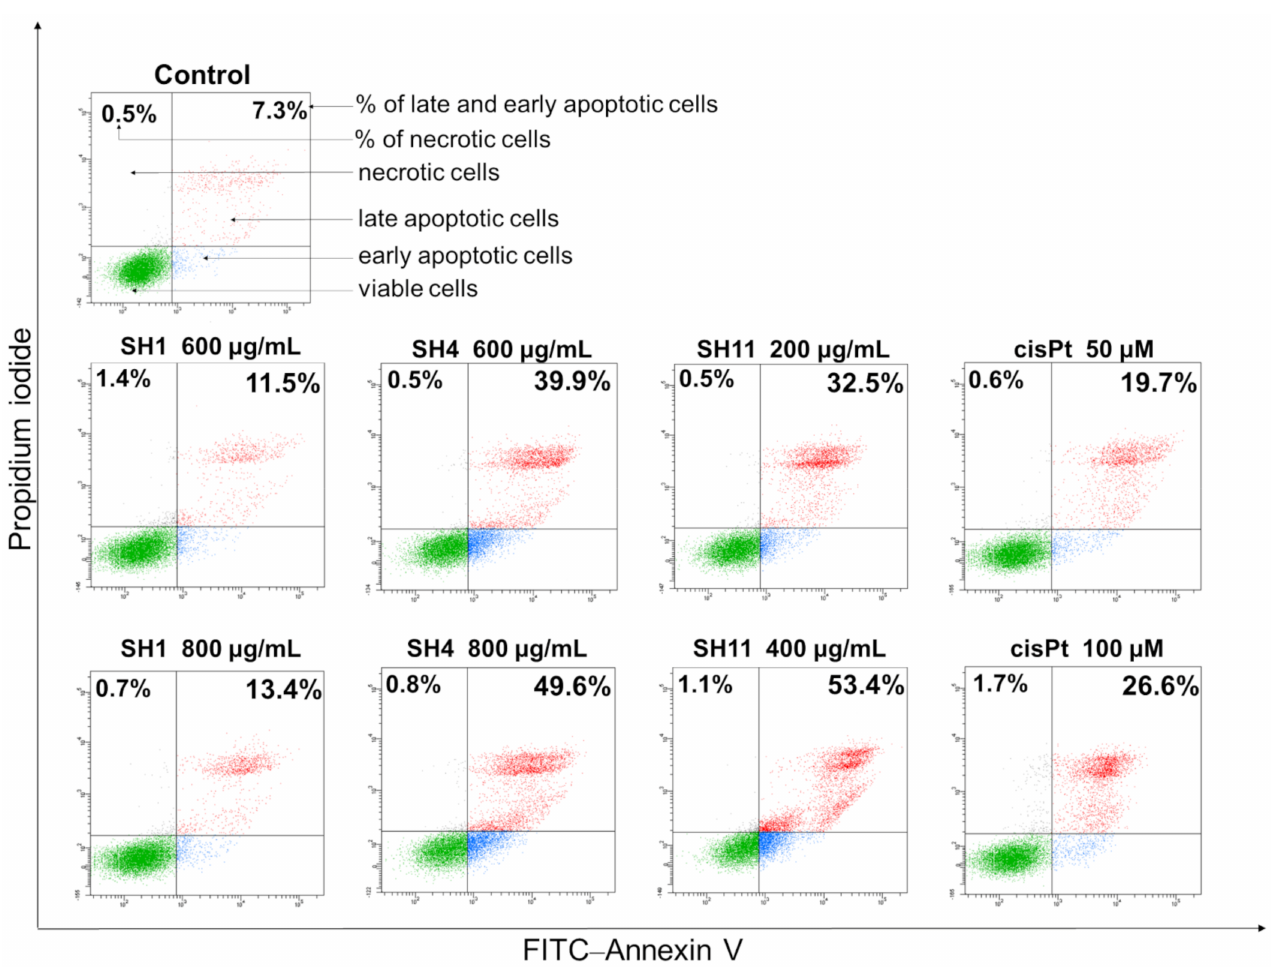
Figure 4. Apoptosis induction in MCF-7 breast cancer cells after 24-h incubation with SH1 , SH4 , SH11 , and cisPt as a reference. The tested concentrations were 600 and 800 µ g/mL for SH1 and SH4 , 200 and 400 µ g/mL for SH11 , and 50 and 100 µ M for cisPt. The number of total early and late apoptotic cells, in addition to the number of necrotic cells, are the mean percentage from three experiments performed in